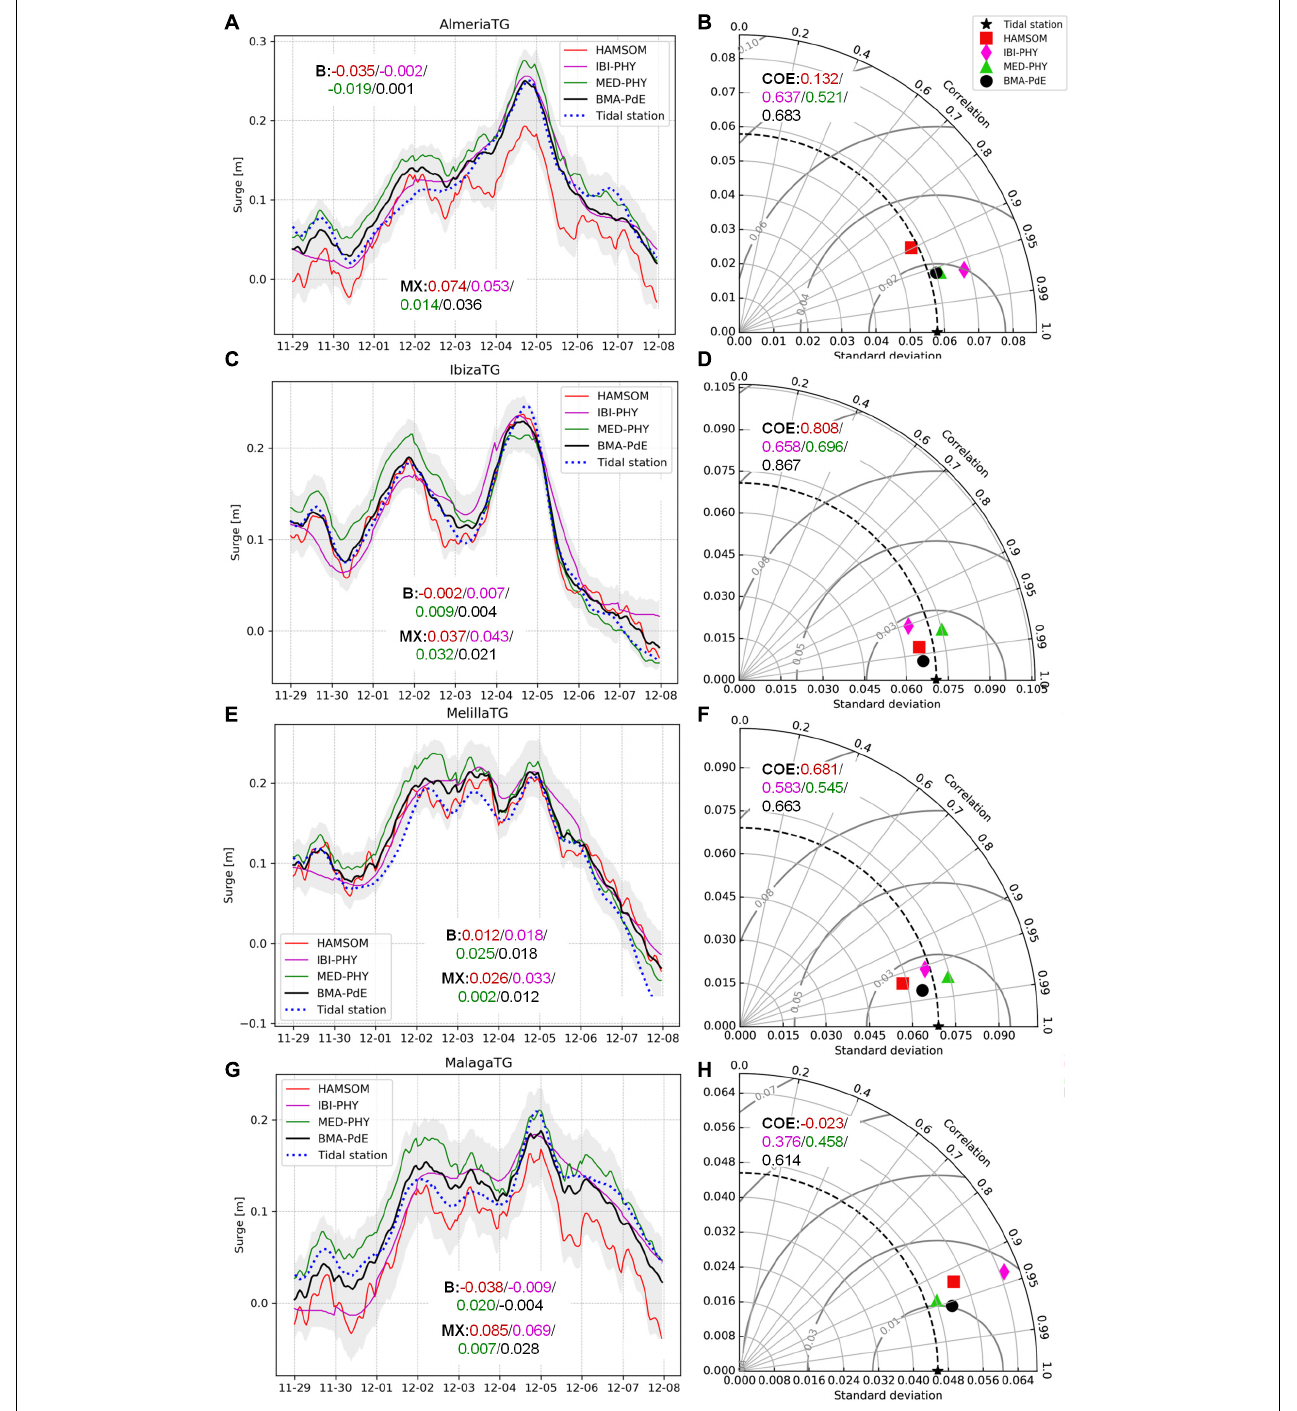
FIGURE 12 | Results of the ENSURF system at several TGs during storm Dora: Nivmar (red), IBI-MFS (magenta), MedFS (green), BMA-PdE (black), and observations (blue). Left panels: surge time series at Almería (A) , Ibiza (C) , Melilla (E) , and Málaga (G) . B is the mean bias for each model, in meters (same chromatic index). MX is the maximum error, in meters. The gray areas enclose the 5-95% percentiles of the ENSURF system. Right panels: Taylor diagrams at Almería (B) , Ibiza (D) , Melilla (F) , and Málaga (H) . Legend: Nivmar (red square), IBI-MFS (magenta rhombe), MedFS (green triangle), BMA (black dot). COE is the Coefficient of Efficiency for each model